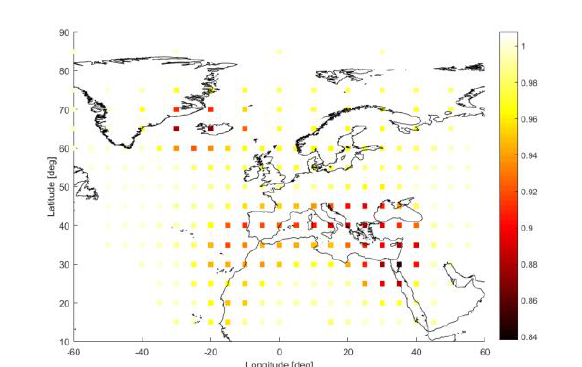
Figure 10. Annual average MLH Normed value from EGNOS and CODE model in 2018